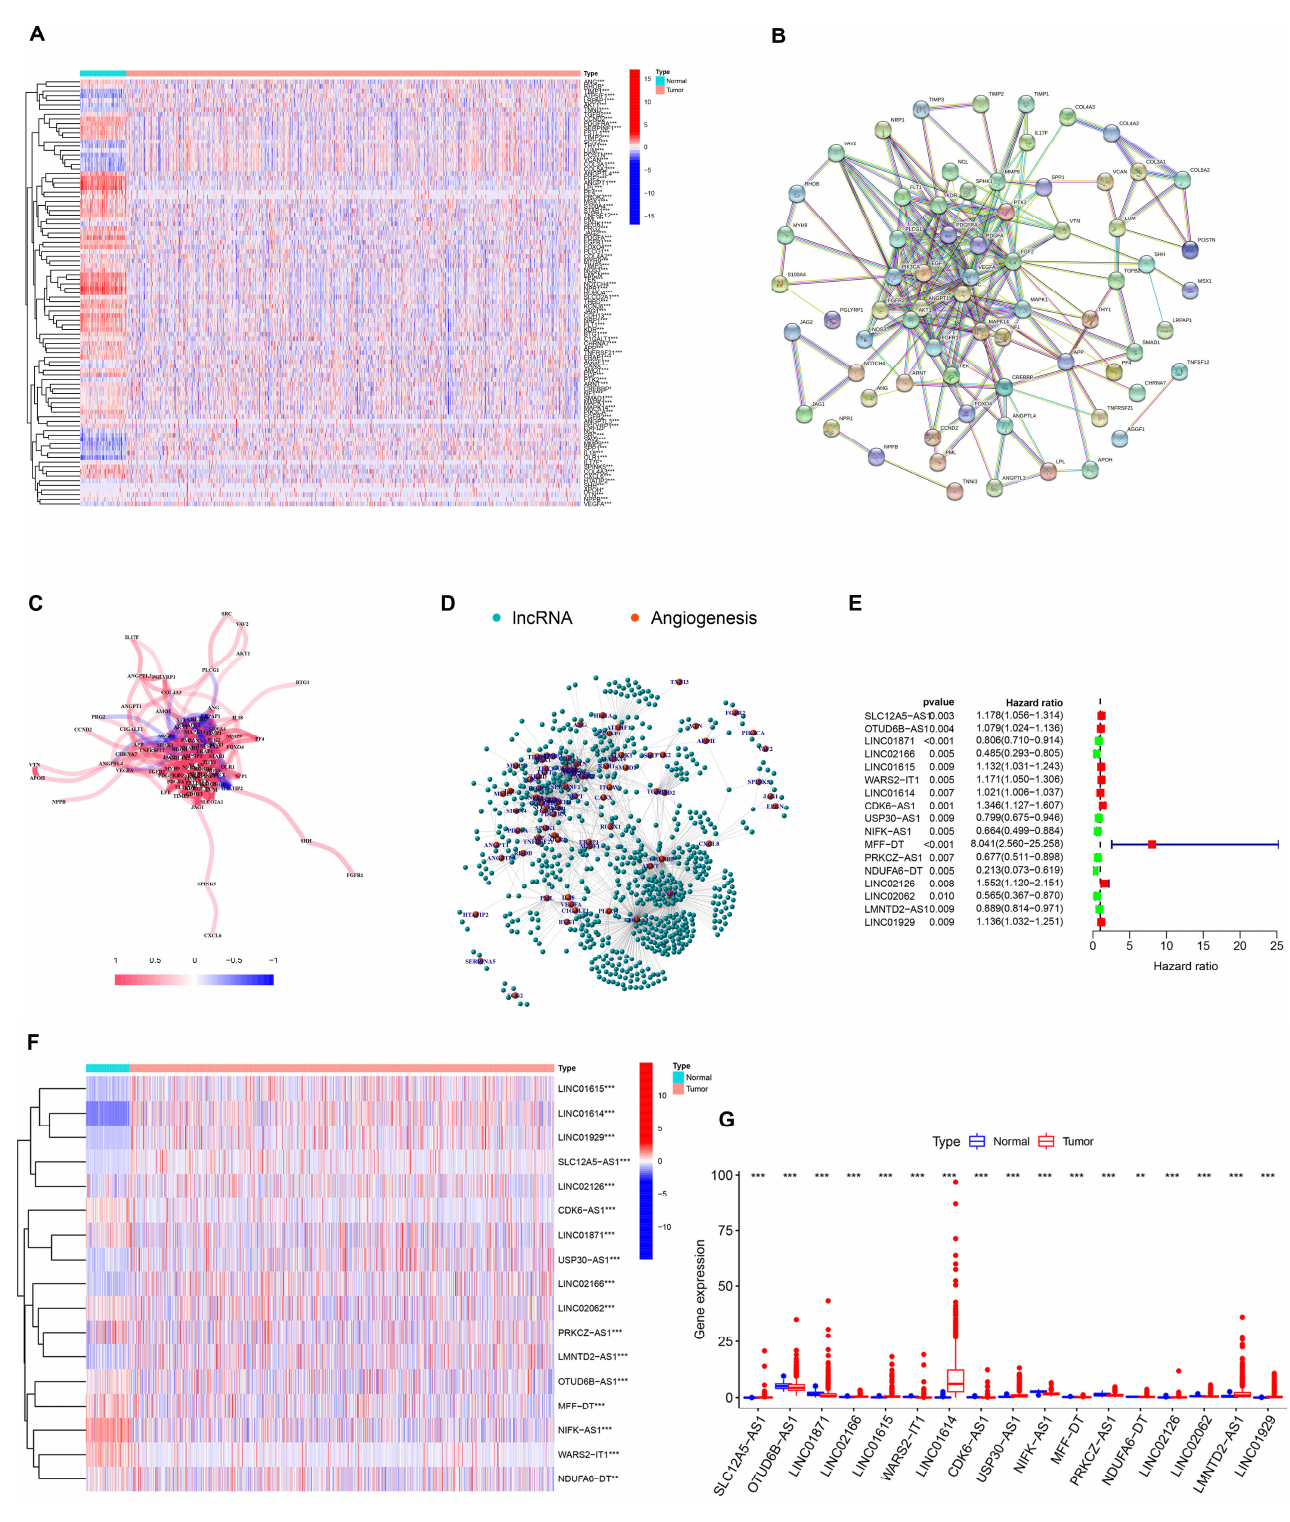
Figure 1. Identification of AR-lncRNAs in BC patients. ( A ) Heatmap of angiogenesis-related genes in BC tissues and normal tissues. ( B ) The interactions among candidate angiogenesis-related genes are shown by the PPI network. ( C ) The correlation network of candidate genes. ( D ) The network of 699 AR-lncRNAs. ( E ) The forest plot of 17 prognostic AR-lncRNAs. ( F , G ) The heatmap and box plot of 17 prognostic AR-lncRNAs in both tumor and normal samples. * p < 0.05, ** p < 0.01, and ** * p < 0.001.